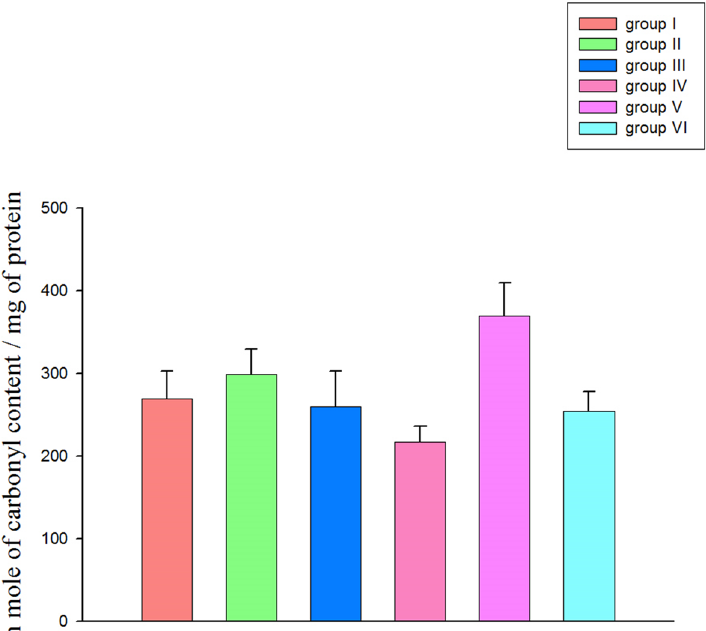
Figure 2. PCC in brains of differently treated mice. Results are expressed as mean ± S.E. a = compared to group I, b = compared to group II, c = compared to group III, d = compared to group IV, e = compared to group V, f = compared to group